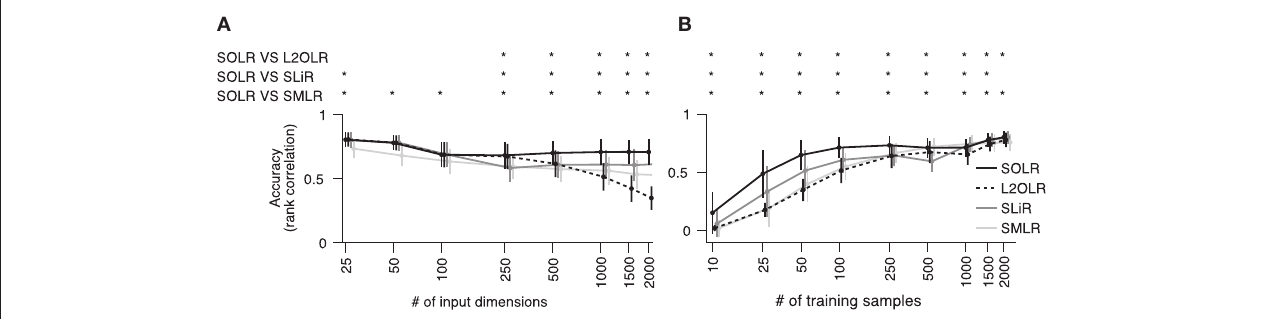
FIGURE 2 | Simulation analysis. (A) Decoding accuracy as a function of the number of input dimensions. SOLR, L2OLR, SLiR, and SMLR are trained with 100 samples and tested with 1,000 samples using simulation data. The prediction performance is evaluated by the Spearman rank correlation between true and predicted labels. In this simulation, only 10 input dimensions include information on labels, and the number of irrelevant dimensions is changed to characterize the performance. The mean performance across 100 simulation repetitions is plotted as a function of the total number of input dimensions (* p < 0.01, signrank test; error bar: SD across 100 simulation repetitions). (B) Decoding accuracy as a function of the number of training data. The mean prediction performance is plotted as a function of the number of training samples (* p < 0.01, signrank test; error bar: SD across 100 simulation repetitions). The total number of dimensions is fixed to 1,000.